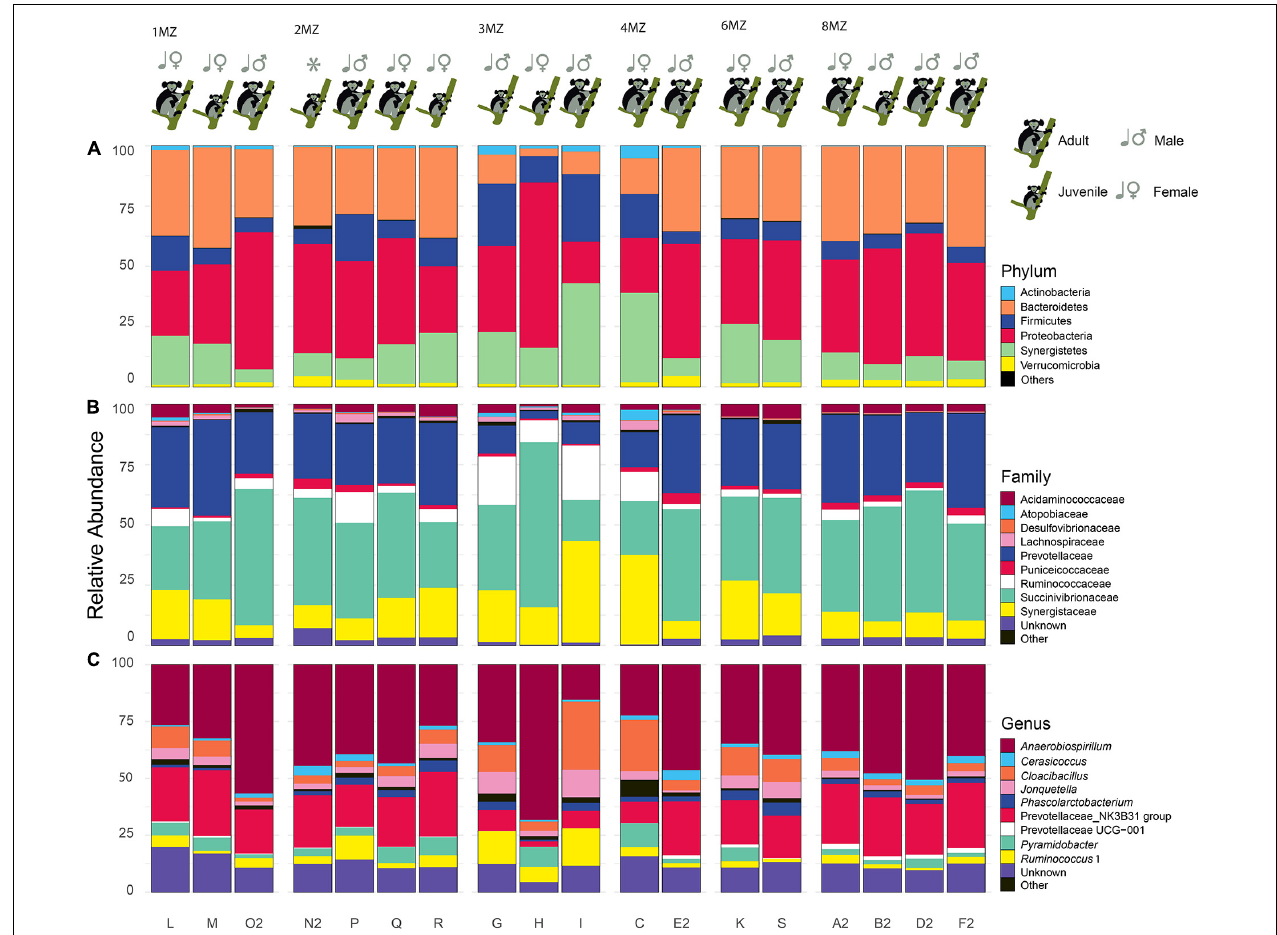
FIGURE 4 | Bar plots of each individual representing the most abundant taxa (average > 1%). Phyum (A) , family (B) , and genus (C) . “Unclassified” represents ASV not classified for the considered taxonomic level. The taxa with a relative average abundance < 1% are collapsed in “Others”. In addition, information regarding family group, class age, and sex is reported on the top of each